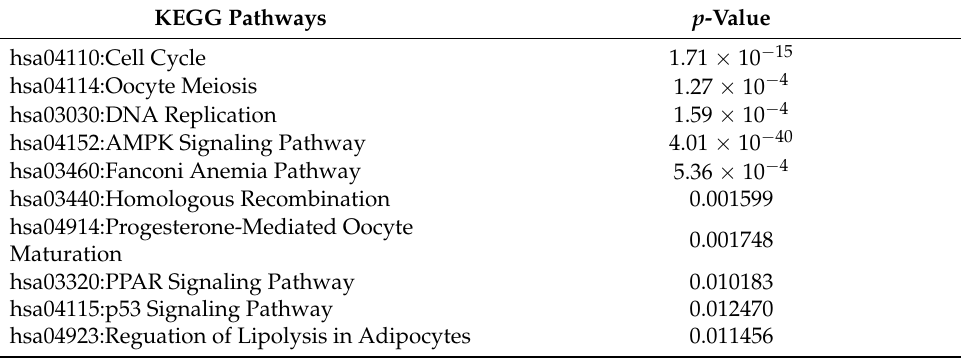
Figure 6. Important KEGG pathways in which the hub genes were significantly enriched. Table 3. Top 10 significantly enriched KEGG pathways with their respective p -values.